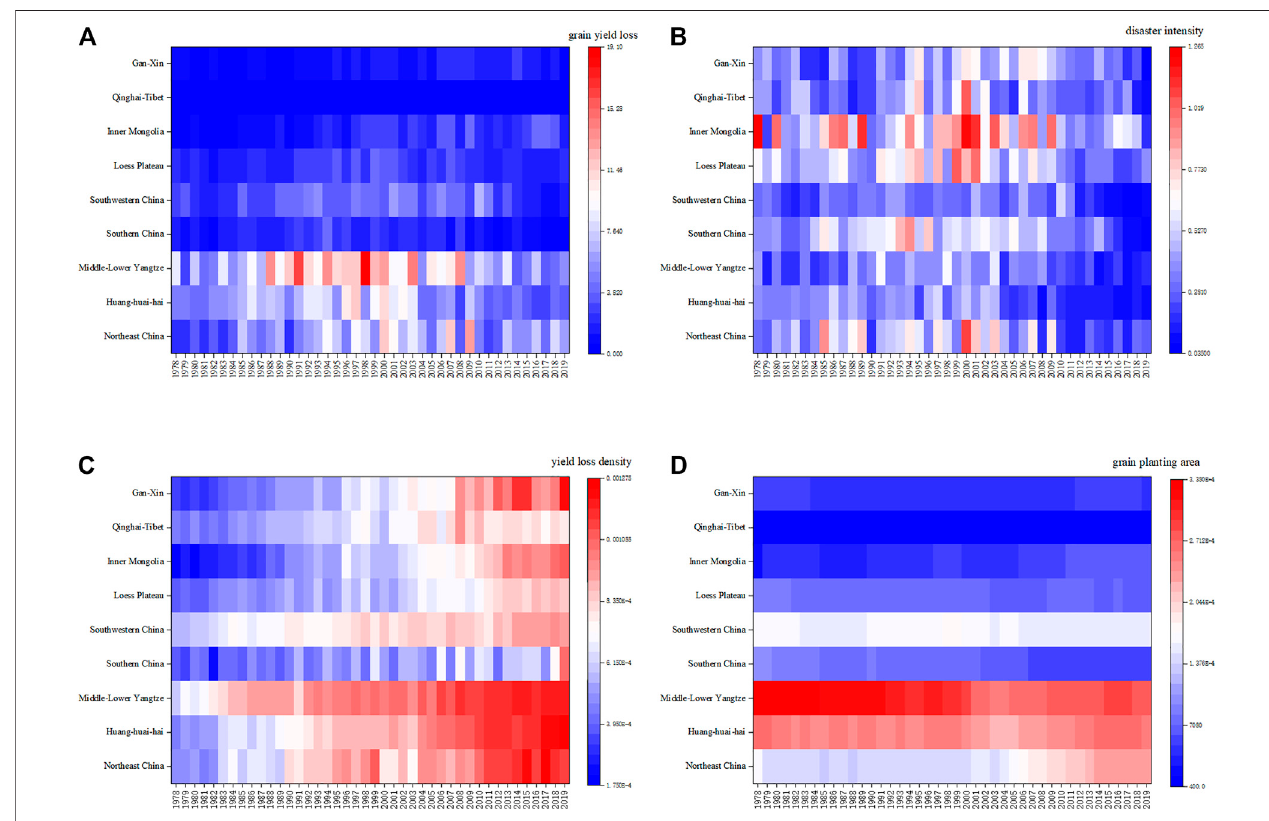
FIGURE 2 | Disaster-induced grain yield loss and the driving factors in nine agricultural regions of China from 1978 to 2019. (A) represents the grain yield loss, (B) represents the disaster intensity, (C) represents the yield loss density, and (D) represents the grain planting area.